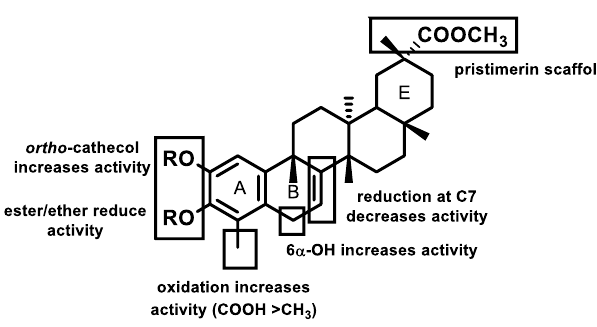
Figure 5. Structural requirements of phenolic nor-triterpenes based on SAR studies.